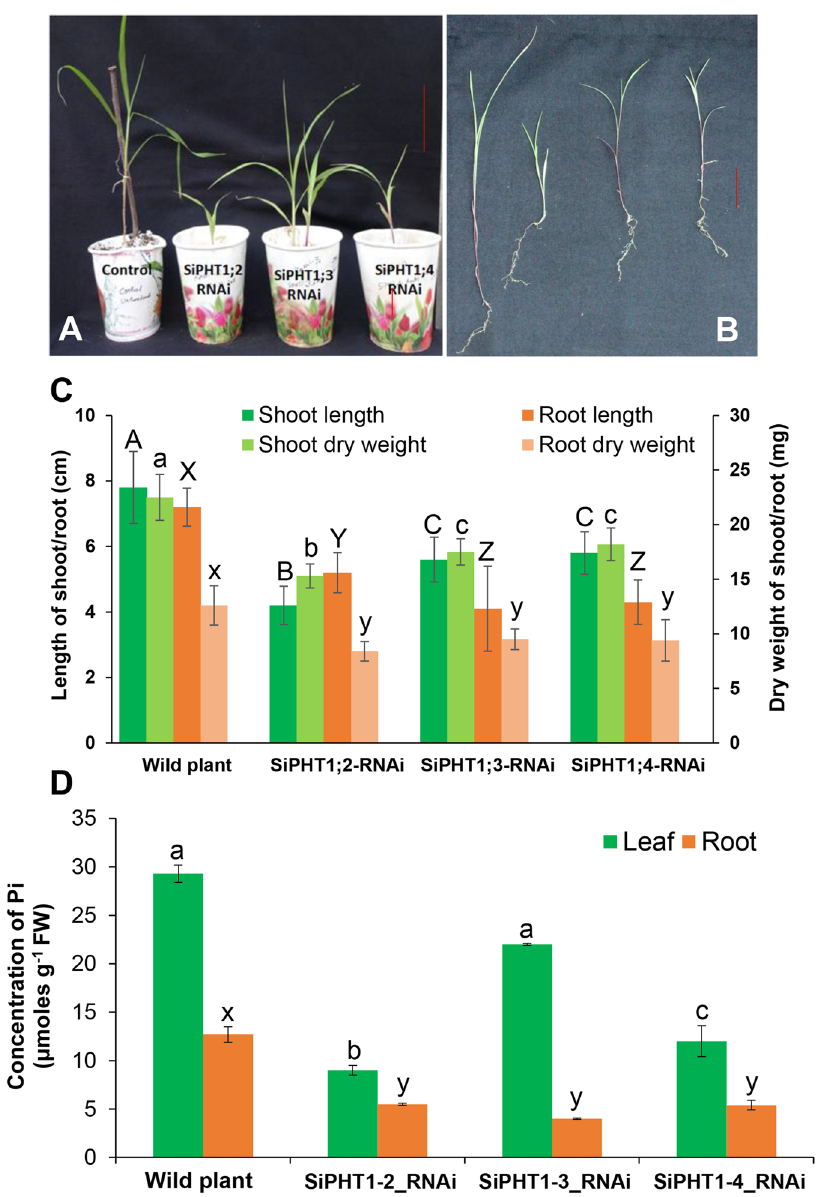
Figure 5. Phenotypic variation of foxtail millet seedlings of T1 lines after transformation with SiPHT1 ; 2 , 3 and 4 RNAi vectors and analysis of Pi content. Three week old seedlings of the 3 RNAi lines and wild type plants grown under low Pi (10 µ M) in paper cups containing perlite ( A ) (bar = 2 cm), seedlings removed from the paper cups showing shoot and root morphology, after 4 weeks of growth ( B ) (bar = 2 cm), shoot length and primary root length and dry weights of root and shoot of 4 weeks old seedlings of 3 RNAi lines and wild plants grown under low Pi ( C ), analysis of Pi content in shoot and root tissues of RNAi lines and wild plants grown under low Pi ( D ). In bar graphs, values are expressed as mean ± SD of 3 replicates ( n = 3 ). Values followed by the same letter are not significantly different ( P > 0 . 001 ) (separately for shoot length, root length, shoot dry weight, root dry weight and leaf and root